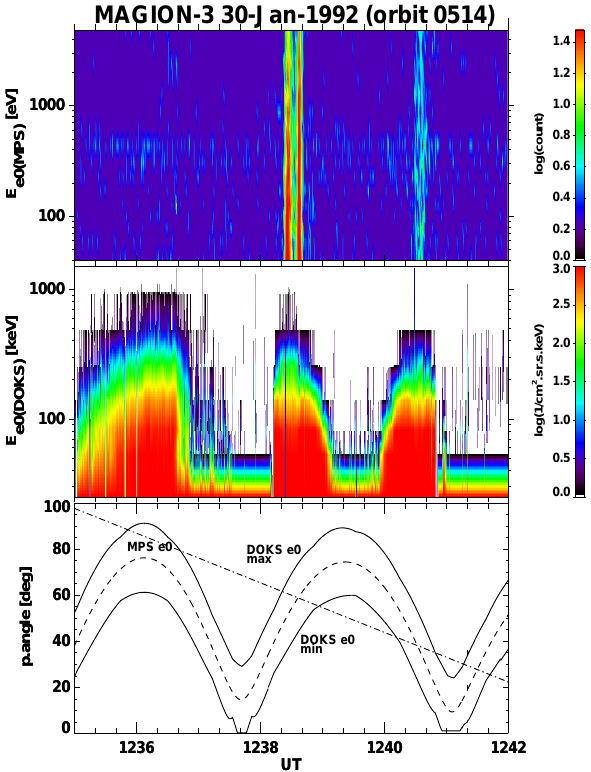
Fig. 5. Simultaneous observations of the electron energy spectra in two shortly separated points. Two top panels show energy spec- tra measured by MAGION-3 (E e0 ( MPS ) and E e0 ( DOKS ) ), the bot- tom panel shows the spectrum measured by the PEAS spectrometer (E 1e6 ( PEAS ) ) onboard the IK-25 satellite. The separation between both satellites was ∼